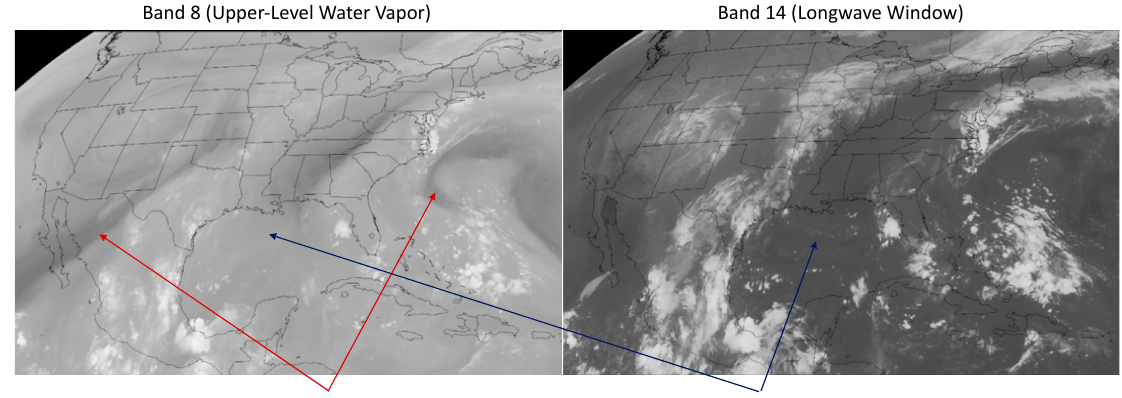
Figure 14. Water vapor (WV) and cloud features as seen B08 and B14 from 10 September 2020 at 12 Z (CONUS image credit: Space Science and Engineering Center at the University of Wisconsin). Compared to an IR window channel (e.g., B14), the WV channels from Bands 8